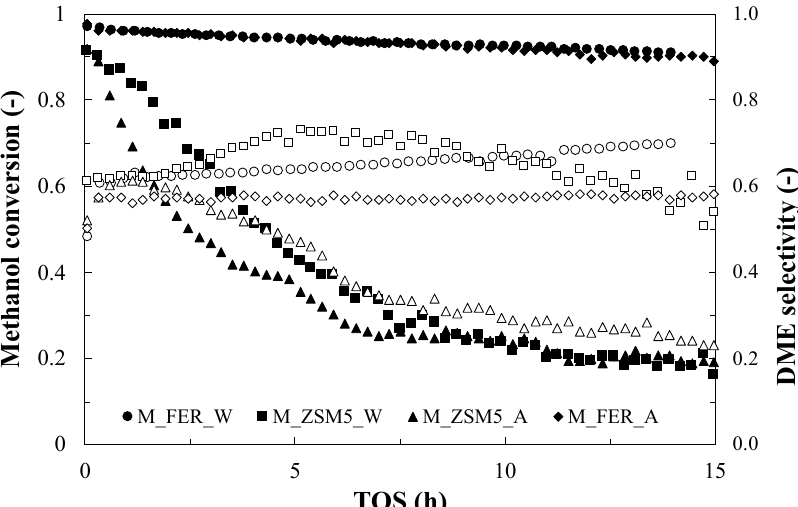
Figure 5. Methanol conversion (closed symbols) and DME selectivity (open symbols) during TOS for the hybrid samples. Test conditions: T = 260 °C; Methanol = 5.6%; Carrier flow rate (N 2 ) = 60 NmL/min; WHSV = 2.3 h − 1 .